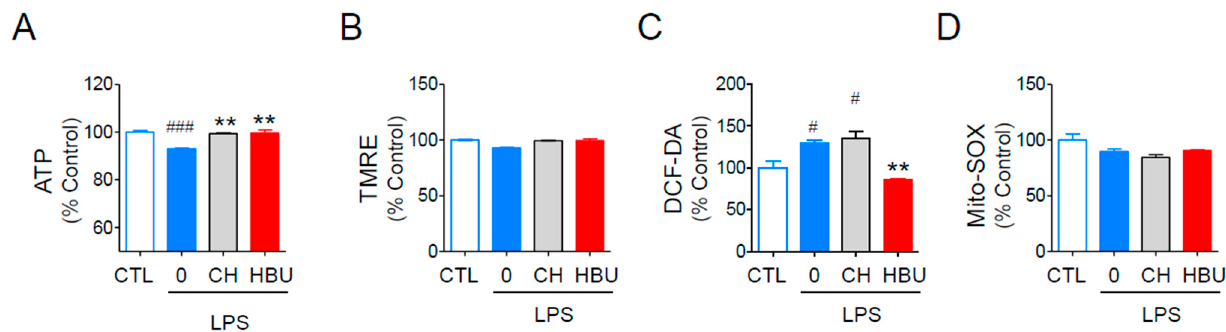
Figure 2. Effects of AhR antagonists on mitochondrial function. Murine BV2 microglial cells on a 96 well plate were pre-treated with 10 µ M HBU651 (HBU) or 1 µ M CH223191 (CH) for 24 h, stimulated with 100 ng/mL LPS for 4 h, and harvested for mitochondrial activity analysis. ( A ) intracellular ATP content, ( B ) TMRE-mediated mitochondrial membrane potential, and ( C ) DCF-DA-based total ROS generation. ( D ) Mito-Sox-based mitochondrial superoxide generation. Data are expressed as the mean ±SEM ( n = 5). # p < 0.05, ### p < 0.001 vs. Control (CTL), and ** p < 0.01 vs. LPS-treated DMSO.